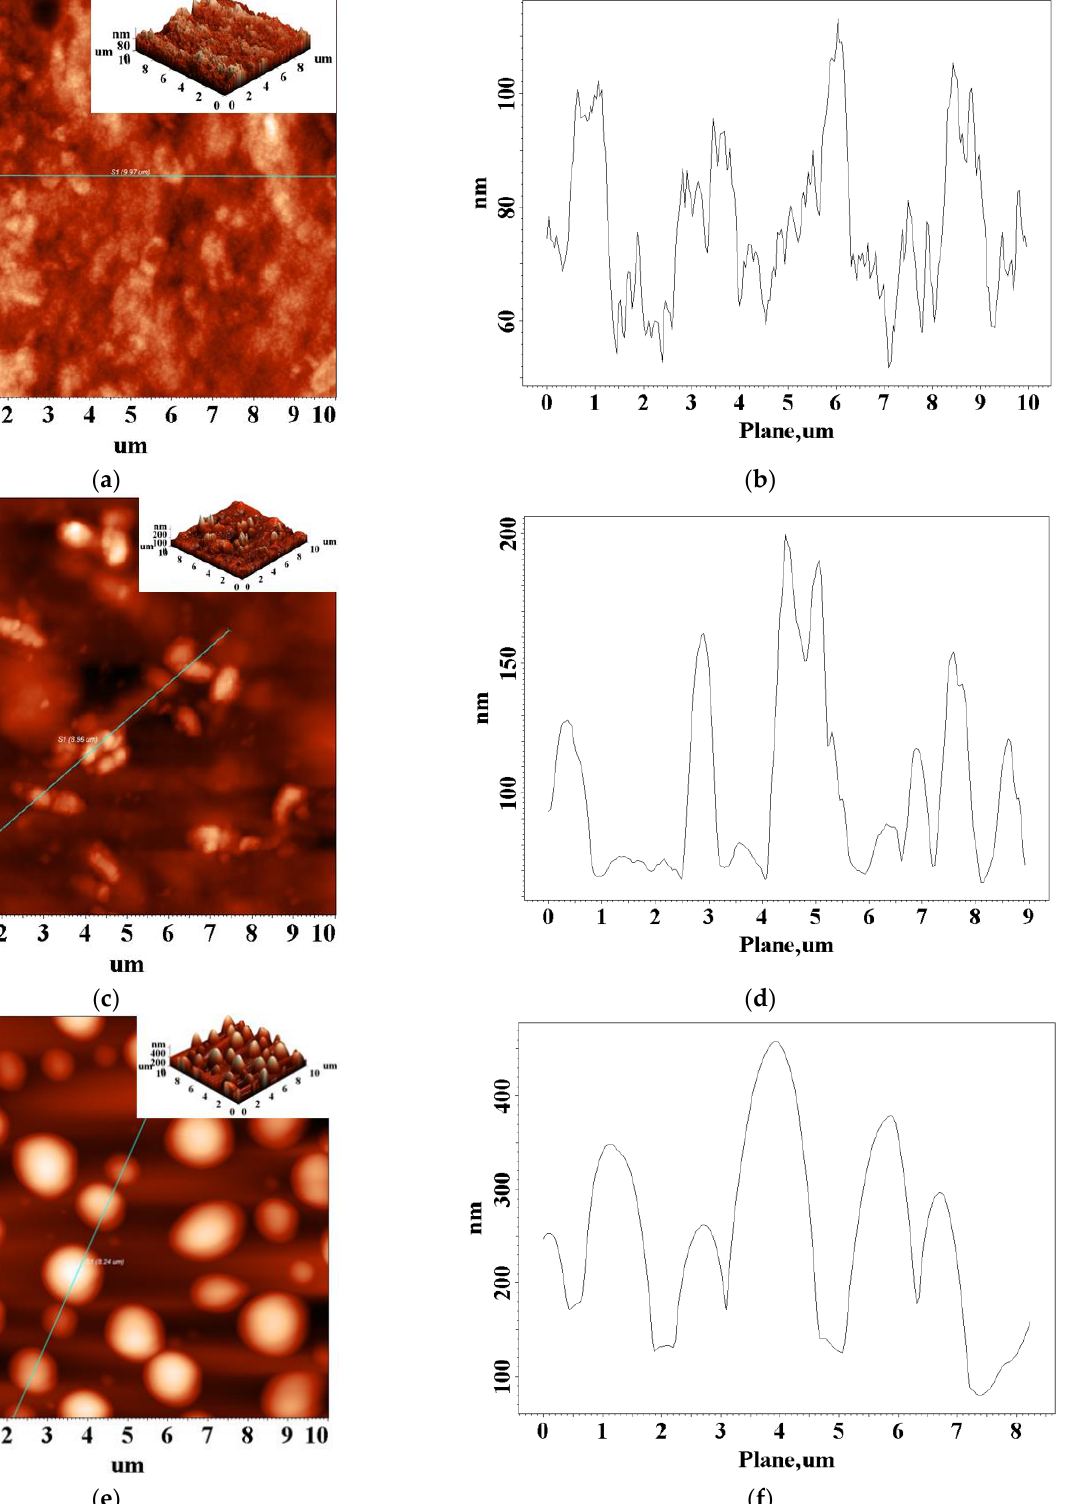
Figure 6. Height - contrast AFM 2D images (3D images as inset) and profiles along the straight line: ( a , b ): XG100.VII; ( c , d ): XG90PVA.III, and ( e , f ): XG50PVA.III. A totally different morphology was revealed by AFM, for the composite cryogels with a weight ratio between XG and PVA of 1:1. The XG50F.III hydrogel composite